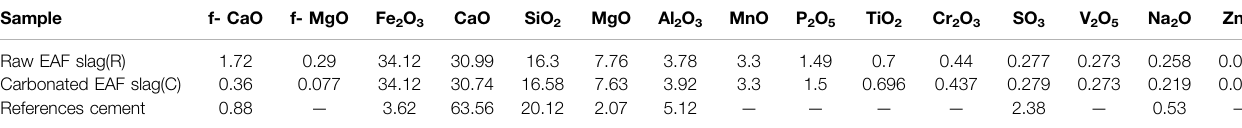
TABLE 1 | Chemical composition of steel slag and reference cement. Sample Raw EAF slag(R)